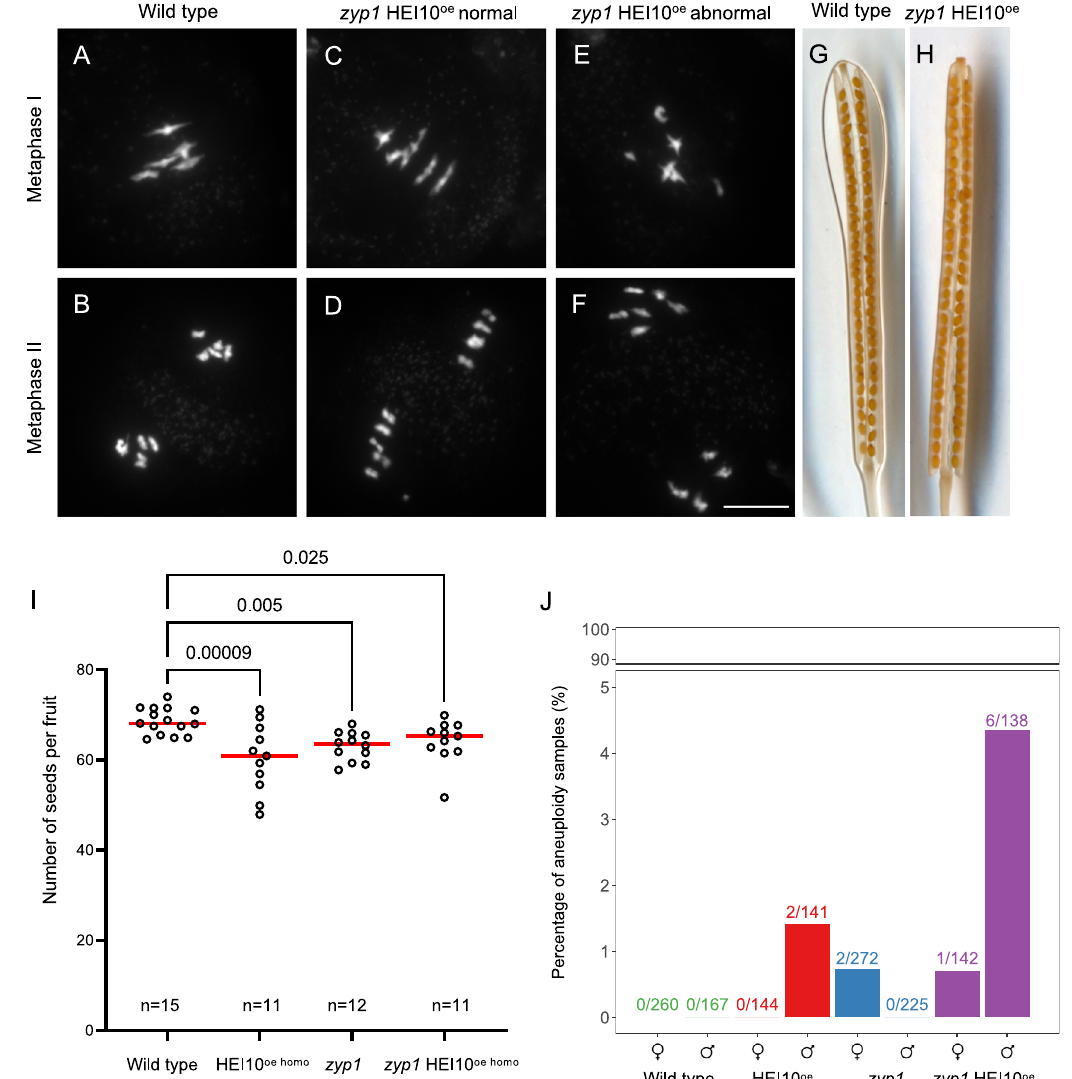
averagedon ten fruits. The red barshows the mean. All plants weresiblings grown together in a growth chamber. The number n of analyzed plants is indicated and P values are one-way ANOVA followed by Fisher ’ s LSD test. J The percentage of aneuploid samples detected in each population (Supplementary Figs. 9 and 10). The proportion of aneuploid samples in each population is shown on top of the bars. Source data are provided as a Source Data fi